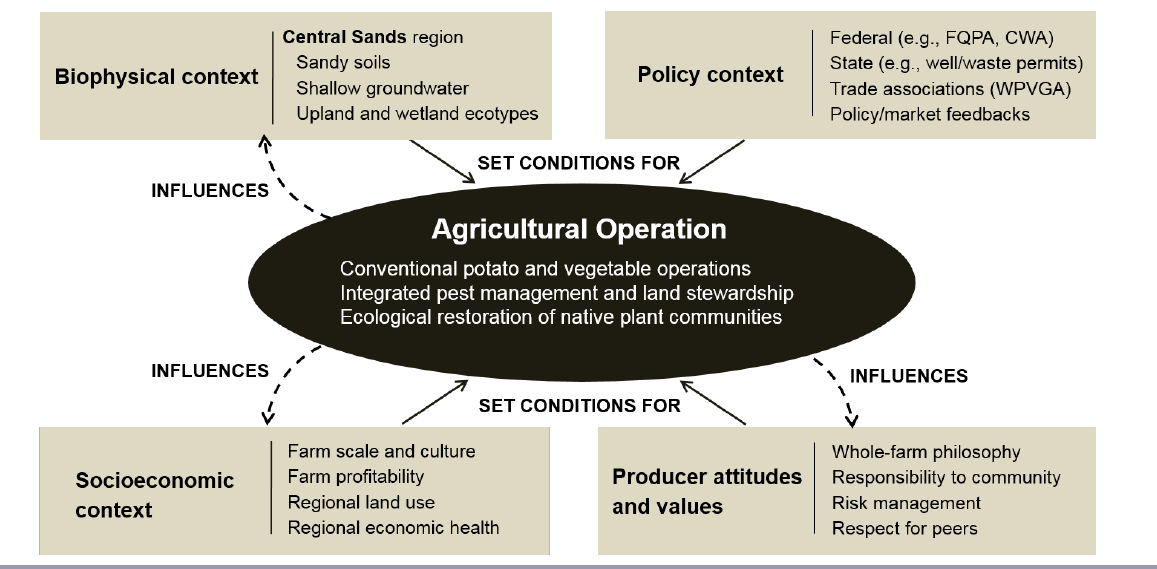
Fig. 1 . Relationships among biophysical, social, economic, and actor contextual factors and their influence on the agricultural operation(s) enrolled in the stewardship network. To be effective tools for improving farm sustainability, management prescriptions and outreach initiatives must account for the social-ecological context of the agricultural operation. Solid arrows represent direct links between drivers; dashed arrows represent feedback interactions. Adapted from Ostrom 2007. (FQPA: U.S. Food Quality Protection Act; CWA: U.S. Clean Water Act; WPVGA: Wisconsin Potato and Vegetable Growers